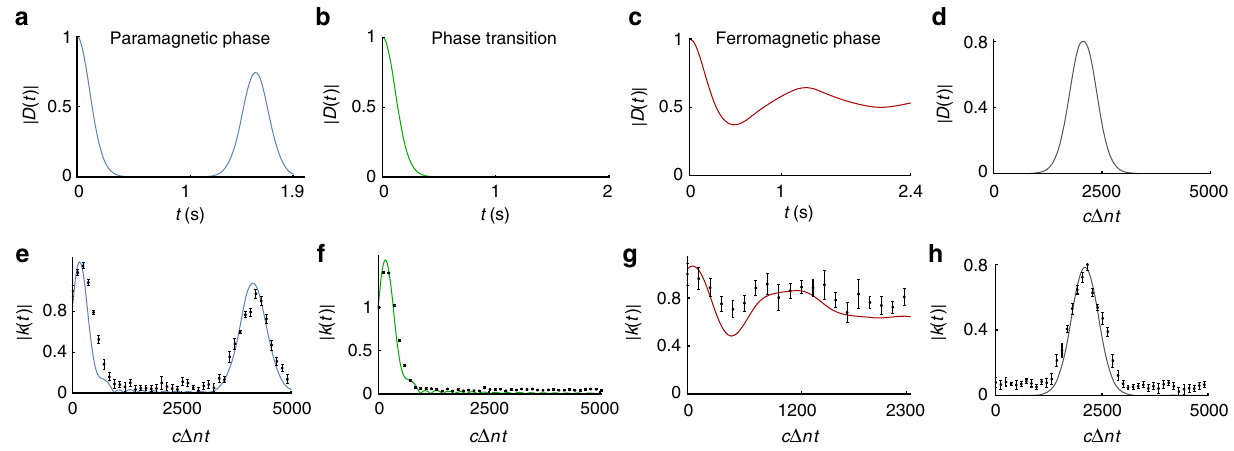
Fig. 2 Model decoherence functions and their simulation. a – c The dynamics of the decoherence function D ( t ) in the spin – Ising chain model as function of time in seconds. a – c correspond to λ = 0.01, λ = 0.9, and λ = 1.8, respectively. d The dynamics of the decoherence function D ( t ) for the dephasing channel Eq. (1) for the case when positivity is broken. e – g Experimental dynamics of the decoherence function | κ ( t )| in the simulator corresponding to panels (a – c) as function of effective path difference in units of 800 nm. The black dots correspond to measurement data and the error bars are mainly due to the counting statistics, which are standard deviations calculated by the Monte-Carlo method. The solid curves are theoretical fi ts for the measurement data which have been obtained by using the width of the photon frequency window as fi tting parameter. h The dynamics of the decoherence function | κ ( t )| when simulating nonpositive map of panel (d). The results clearly display the dynamical property | κ ( t )| > | κ (0)| over a long interval of time